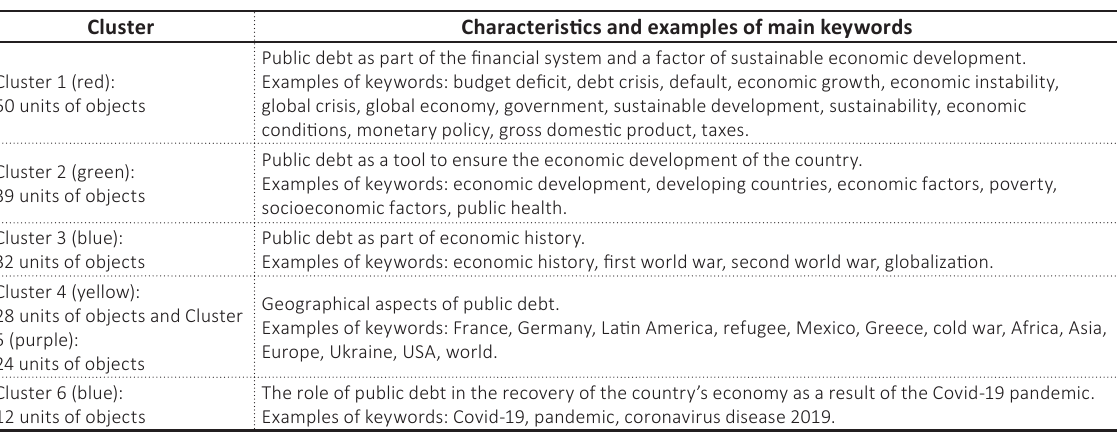
Source: Compiled by the